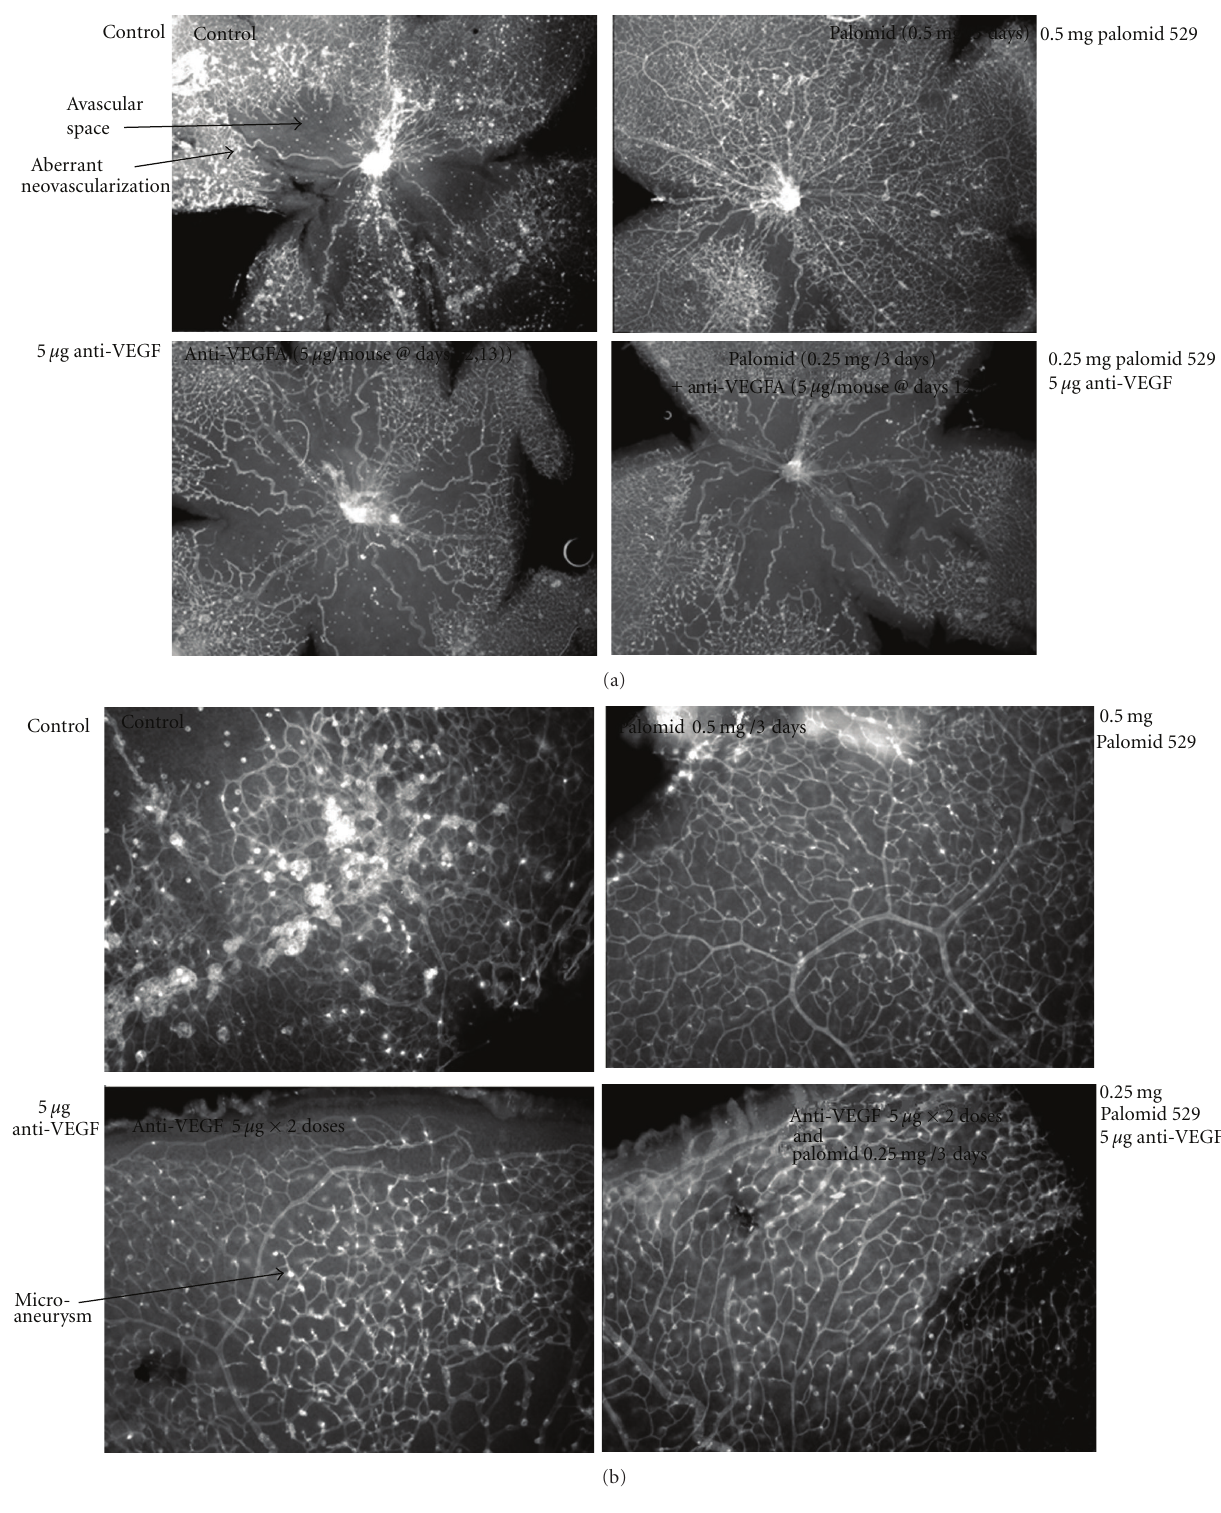
Figure 2: Oxygen-induced retinopathy model-retinal flat mount. Seven-day old SV129 mouse pups were put at 70% oxygen for 5 days, removed to normal air, and injected intraperitoneal with Palomid 529 for 5 days. The animals were then sacrificed and the eyes removed and fixed in 10% formalin for 30 min. The retinas were isolated, blocked for 1hr in PBS containing 1% BSA, 1% goat serum, and 0.5% TX-100, stained overnight with 10 μ g/mL BS-1 lectin labeled with FITC (Sigma-Aldrich), washed in PBS and flat